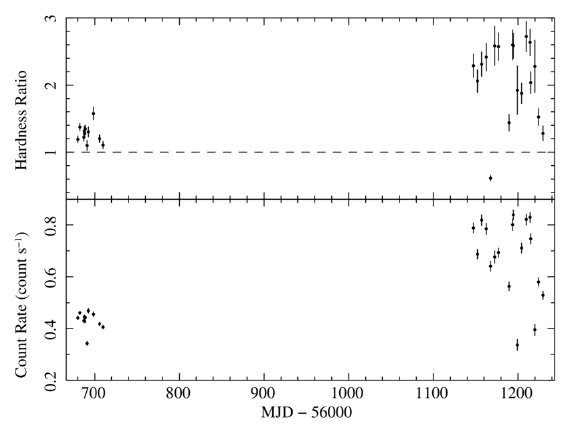
Figure 2. hardness ratio (top panel) and light curve (bottom